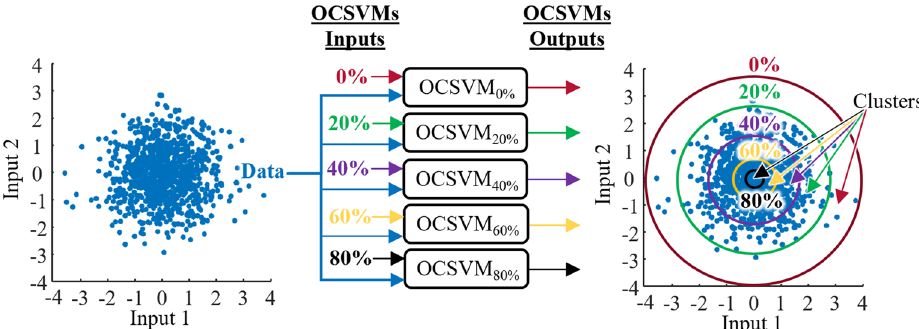
Figure 1. Prediction interval algorithm schematic featuring arbitrary data. Raw data are fed to multiple one- class support vector machine (OCSVM) models with their respective, user-defined, percentage of outliers. The outputs of the OCSVMs are hyperplanes that are projected on the two-dimensional input space (circles in this example). The clusters are upper and lower bounded by the hyperplanes (except inside 80% and outside